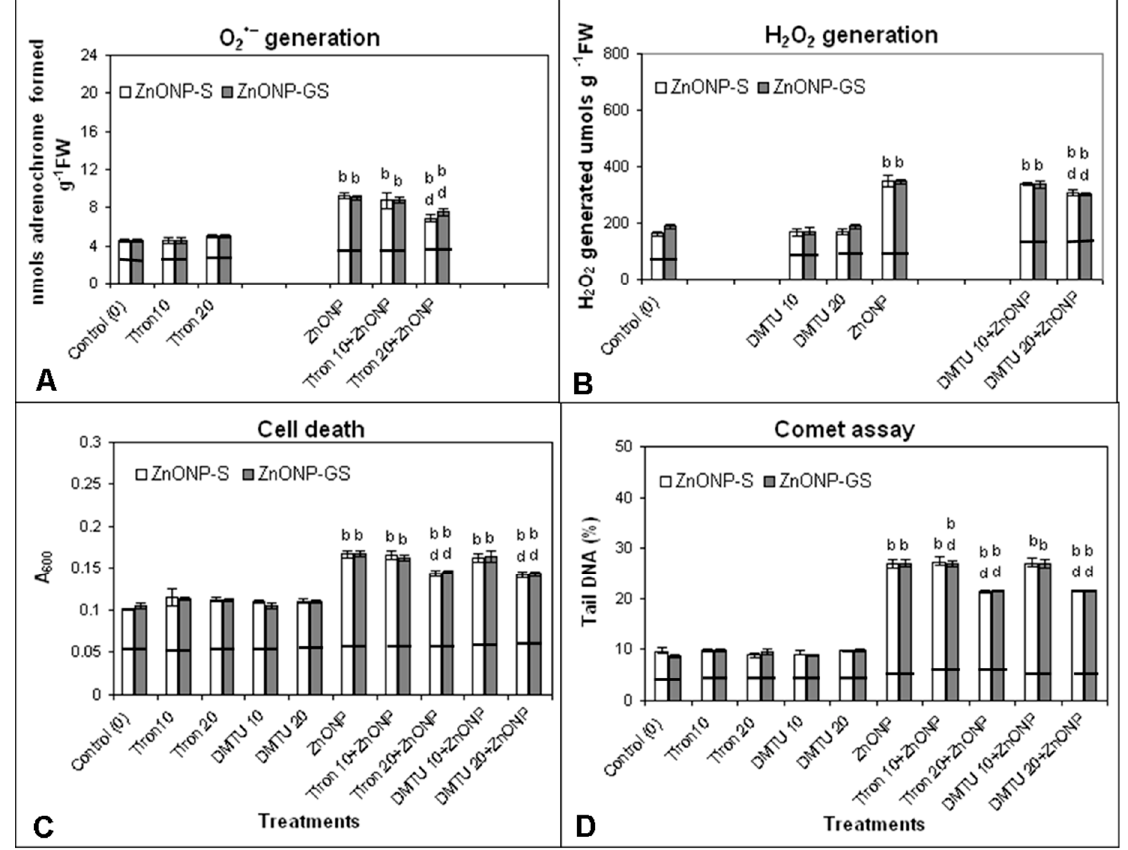
Figure 10. Effect of Tiron- or DMTU-priming at concentrations of 10 and 20 µ M on the induction of ( A ) O 2 •− generation, ( B ) H 2 O 2 generation, ( C ) cell death, and ( D ) DNA damage in roots of germinating seeds of C. gigantea treated with ZnONP-GS at 80 mg L − 1 . Increase significant at p ≤ 0.01 (b) compared to the control (0), and decrease significant at p ≤ 0.01 (d) compared to ZnONP-GS. The horizontal bar denotes no significant difference between the treatments at p ≤ 0.05, ( n = 6).